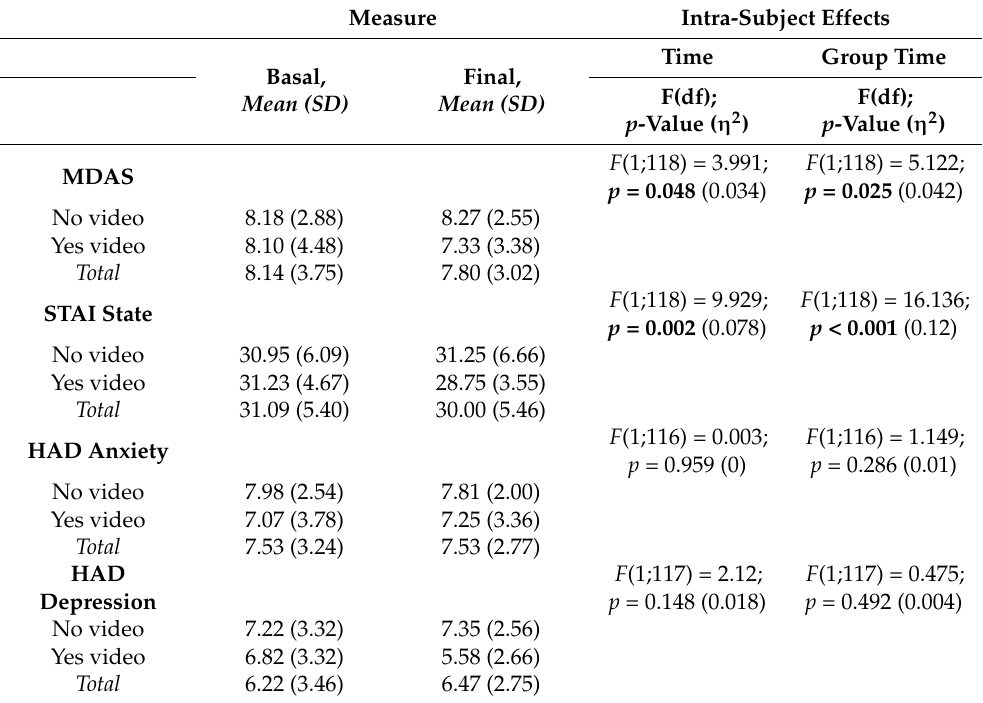
Table 5. Means (SD) and statistical contrasts between groups of the scales Corah’s Modified Dental Anxiety Scale